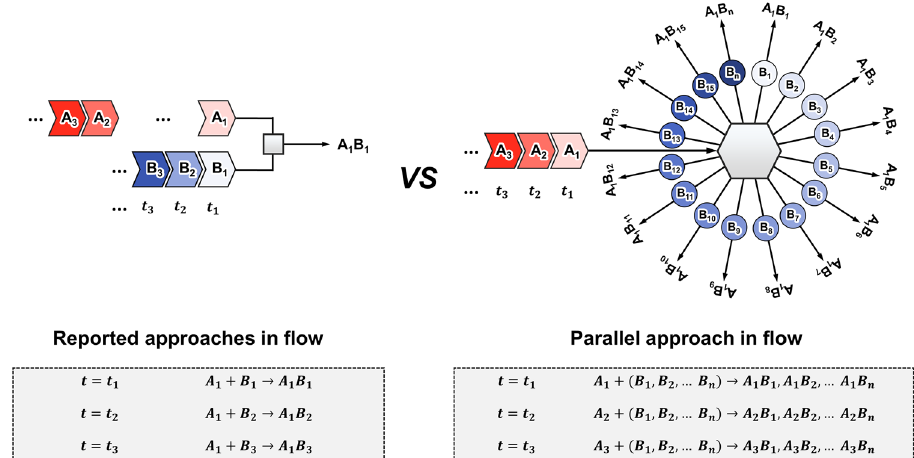
Fig. 1 Comparison of the reported approach and our parallel approach in fl ow system. The reported approaches (left) in fl ow system mostly performs A i × B j type reactions sequentially. On the other hand, our parallel approach (right) uses the fl ow parallel synthesizer to enable composite combinations of A i × (B 1 , B 2 , B 3 ... B n ) in multiple modes in a single